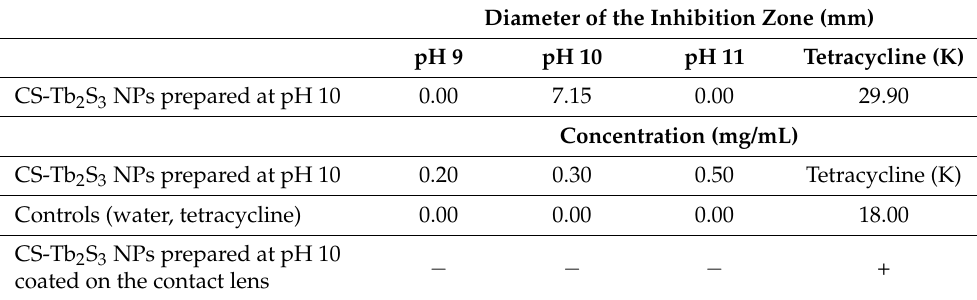
Figure 5. The antibacterial effect of CS-Tb 2 S 3 NCs as antibacterial agents. (+): inhibition and ( − ): absence of inhibition, where tetracycline was used as a positive (+) control (yellow arrow) and water was used as a negative ( − ) control in the center of the petri dish. Table 5. Average diameter of the inhibition zone of CS-Tb 2 S 3 NCs against S. aureus .